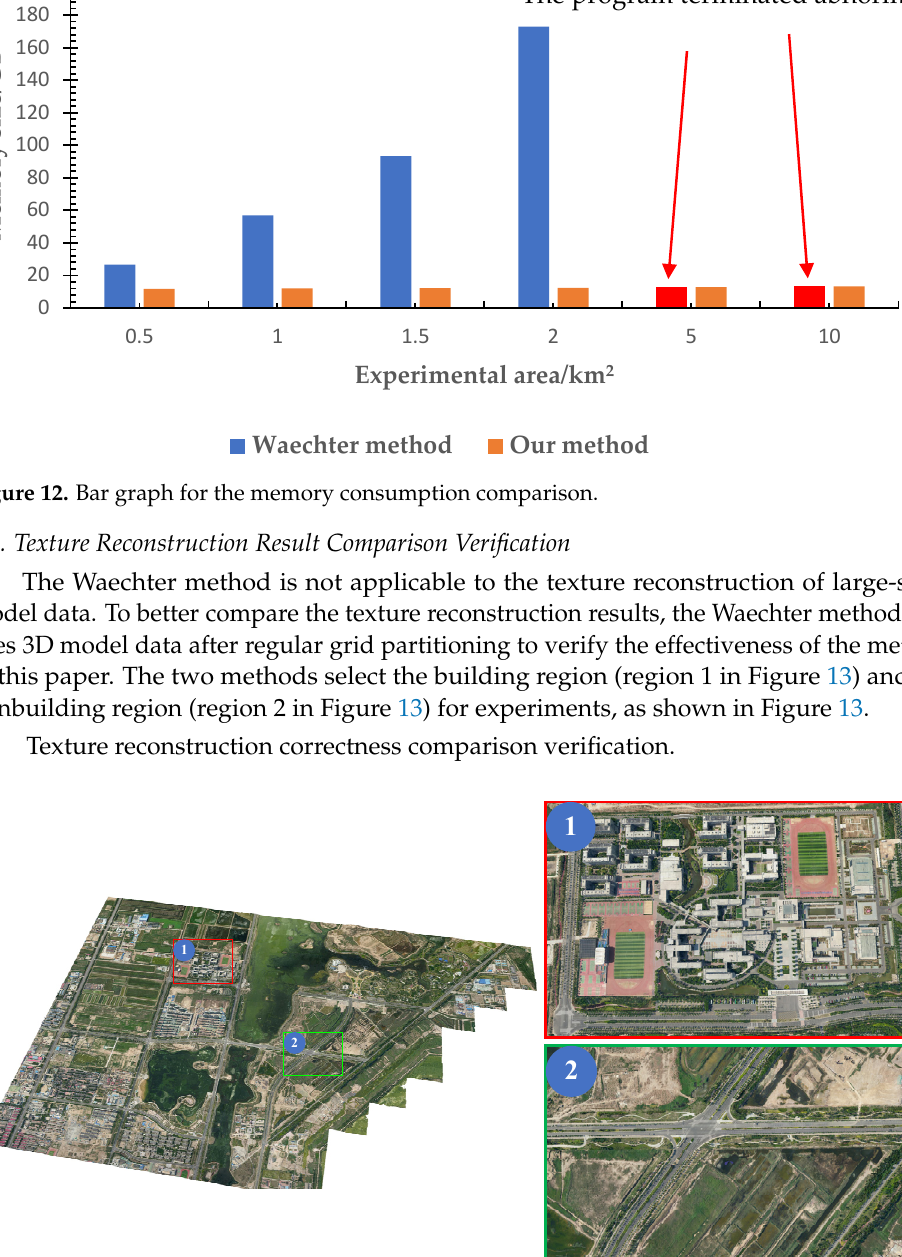
Figure 12. Bar graph for the memory consumption comparison.